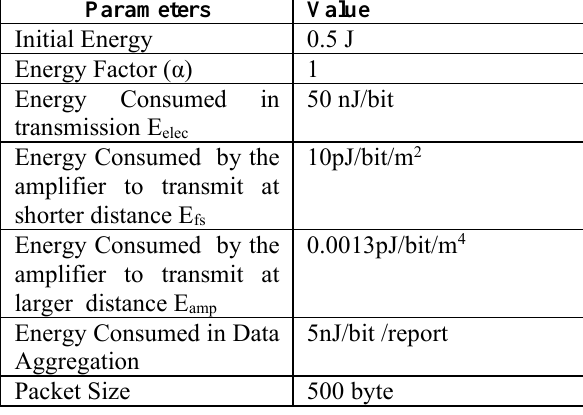
Figure 2. Proposed protocol of node deployment Table 12. Parameter table for